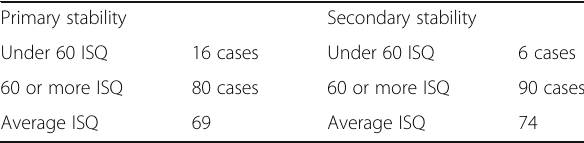
Table 2 Implant primary and secondary stability Primary stability